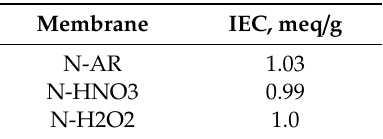
Table 2. IEC experimental values.